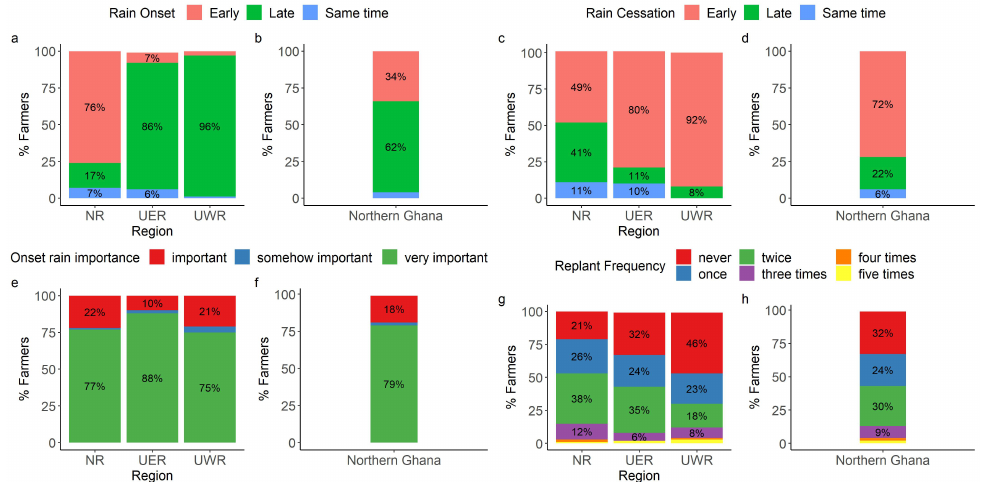
Figure 9. Farmers’ perceptions of the rainfall onset trend per region ( a ) and aggregated in entire Northern Ghana ( b ). Cessation for each region ( c ) and aggregated for the entire Northern Ghana ( d ). The importance of the onset date of the rain on the yield of the main crop per region ( e ) and whole Northern Ghana ( f ). The frequency of replanting of seeds of the main crop in the last 5 growing seasons due to the false start of the rain season per region ( g ) and aggregate for northern Ghana ( h